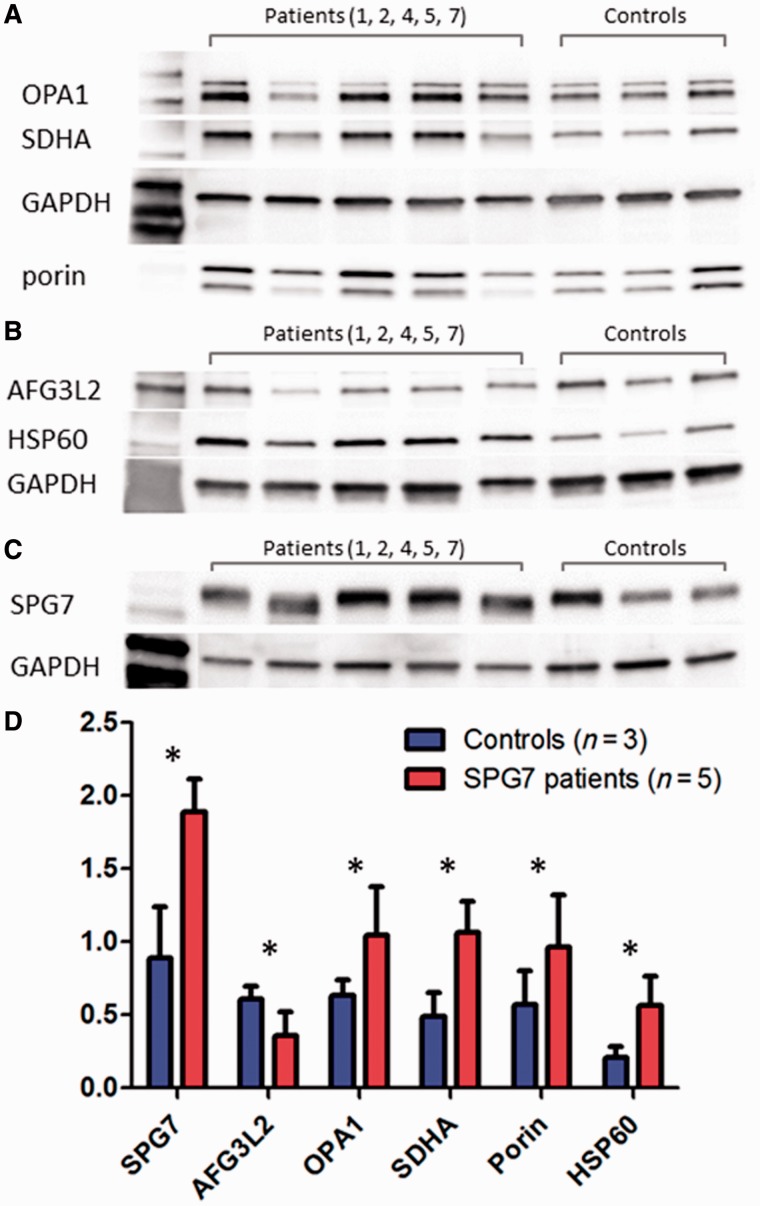
Western blot of muscle tissue. (A–C) Representative blots used in the quantification of protein expression of muscle tissue from five patients with compound heterozygous SPG7 mutations and three control subjects. Testing was performed in triplicate and quantification of aggregate mean with SD (normalized to GAPDH) are represented in D. Markers of mitochondrial mass, including SDHA, porin, and HSP60 are significantly increased in SPG7 patients compared with controls. SPG7 and OPA1 were also significantly elevated in SPG7 patients compared with controls. AGF3L2 was decreased compared with controls. All the above were statistically significant to *P < 0.01.